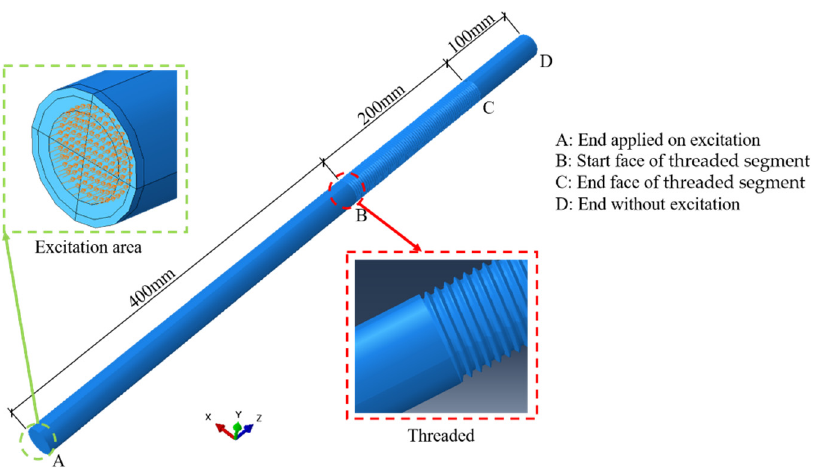
Figure 4. Numerical model of threaded rod.